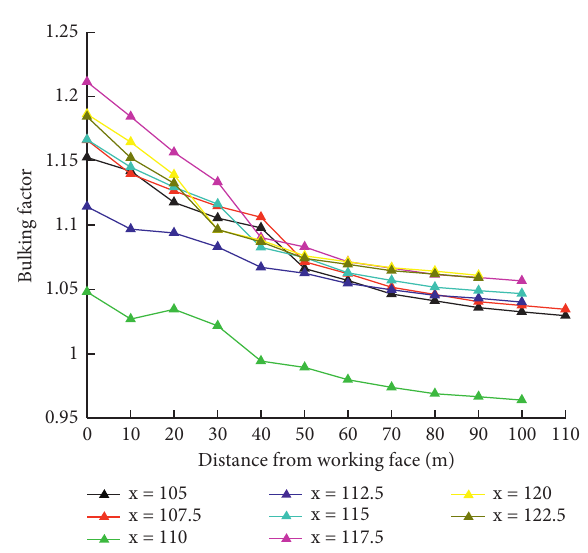
Figure 11: Evolution of the bulk factor with the longwall